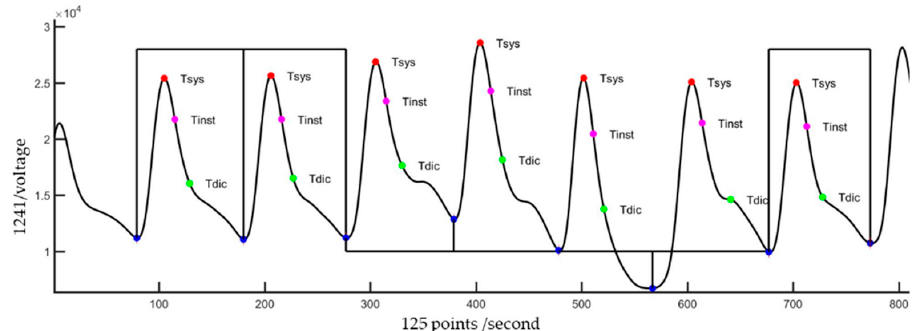
Figure 7. A signal segment in the duration of PCA has seven pulses. When the quality of the pulse wave is good, a high level is marked in the corresponding cycle. Otherwise, a low level is marked.